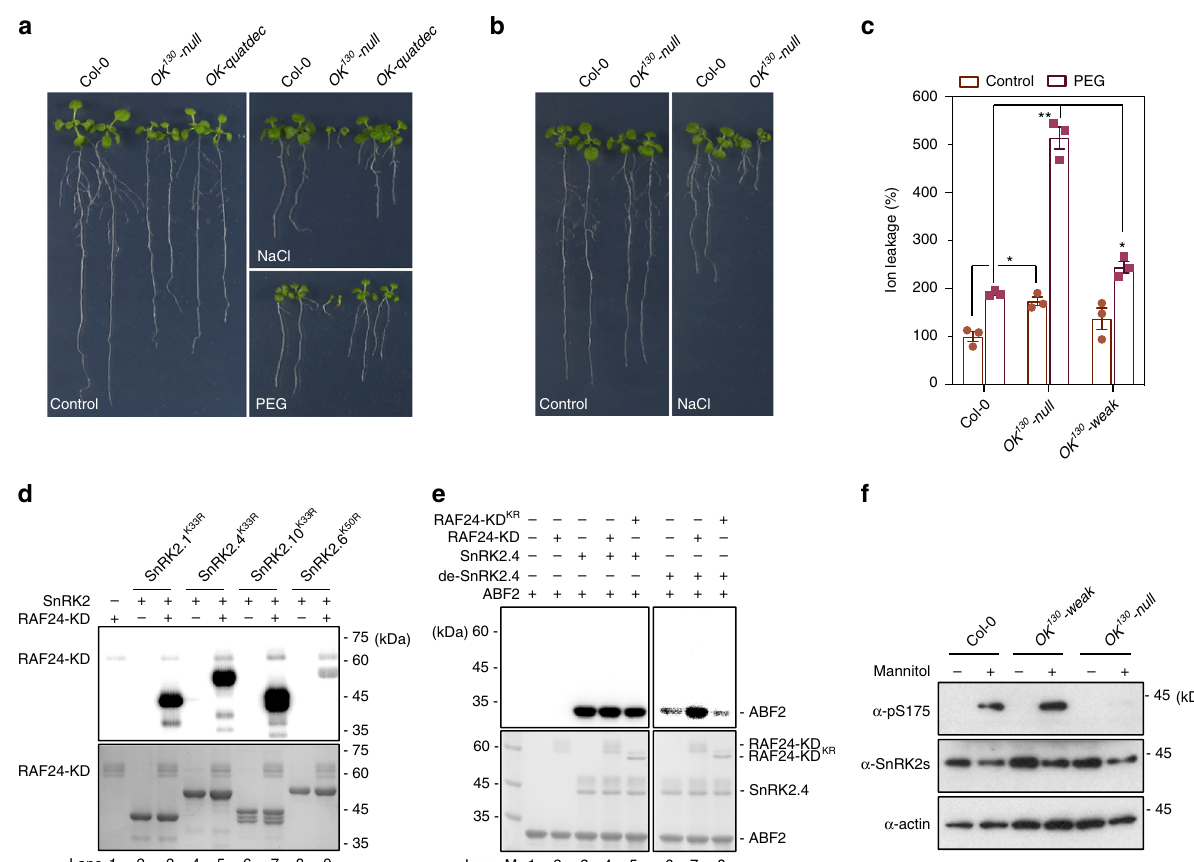
Fig. 4 RAF de fi ciency alters osmotic stress sensitivity. a Photographs of seeds after 10 days of germination and growth on 1/2 Murashige and Skoog (MS) medium containing 100 mM NaCl or − 0.5 MPa PEG. b Photographs of seedlings 7 days after transfer to and growth on 1/2 MS medium containing 100 mM NaCl. c Osmotic stress sensitivity as measured by electrolyte leakage in seedlings treated with 30% PEG. Error bars, SEM ( n = 3). Two-tailed paired t -tests, * p < 0.05, ** p < 0.01. d RAF24-KD phosphorylates SnRK2s in vitro. Recombinant RAF24-KD was used to phosphorylate SnRK2s expressed and puri fi ed from E. coli in the presence of [ γ - 32 p]ATP. Autoradiograph (upper) and Coomassie staining (lower) show phosphorylation and loading of puri fi ed RAF24-KD and SnRK2s, respectively. e RAF24 activates dephosphorylated SnRK2.4 in vitro. RAF24-KD enhances the activity of pre- dephosphorylated SnRK2.4 (de-SnRK2.4) (right panel), but not the activity of SnRK2.4 without pre-dephosphorylation (left panel). Phosphorylation of ABF2 fragment was used to indicate the SnRK2.4 activity. Autoradiograph (upper) and Coomassie staining (lower) show phosphorylation and loading of puri fi ed RAF24-KD and SnRK2.4, respectively. f The mannitol-induced phosphorylation of the conserved serine corresponding to Ser175 in SnRK2.6 depends on RAFs. Source data are provided as Source Data fi